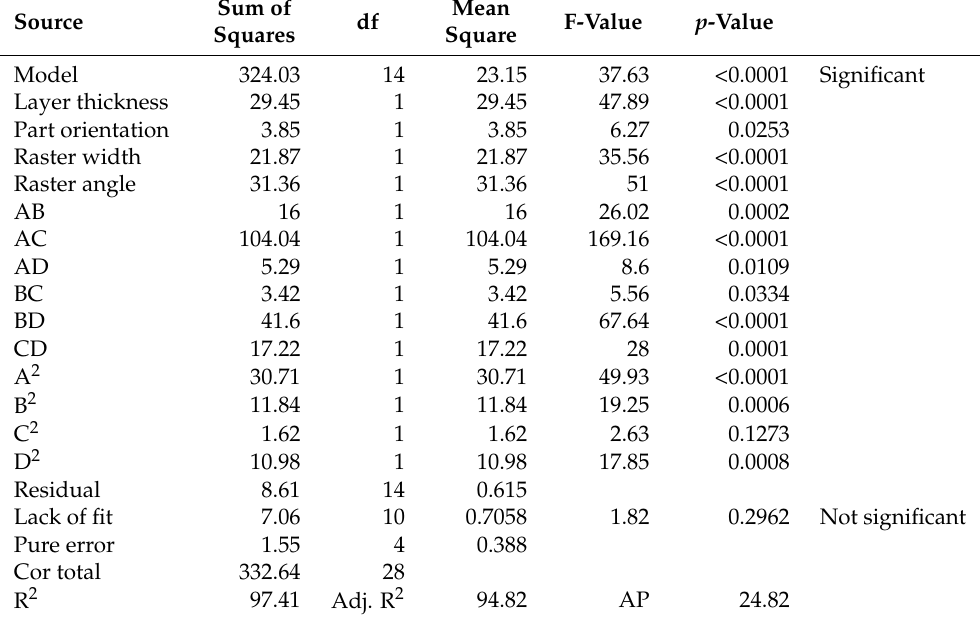
Table 4. Statistical analysis for Rz